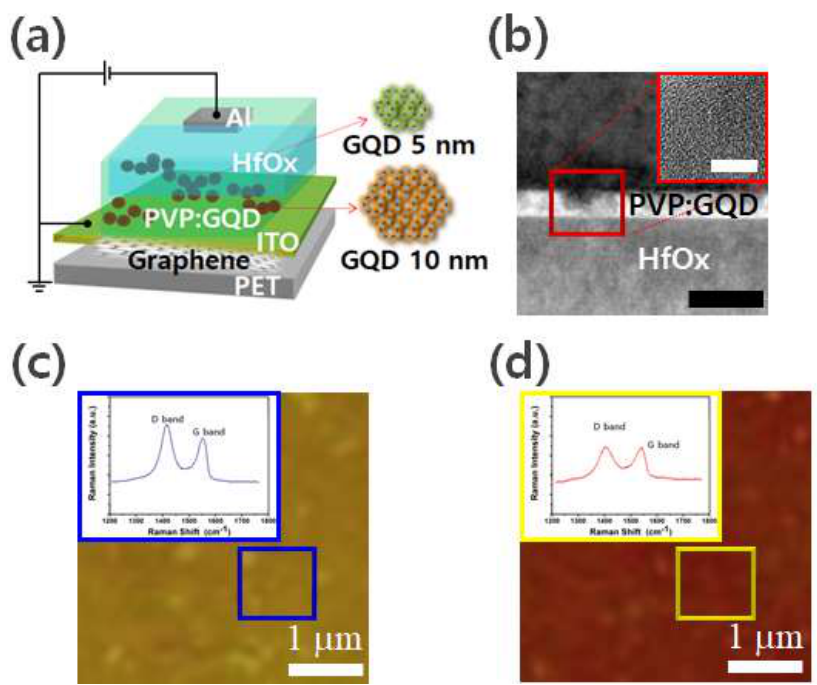
Figure 1. Schematic illustration ( a ) of the device architecture based on PVP GQD/HfOx/ITO/graphene. ( b ) and TEM image of PVP GQD/HfOx layer. The scale bar indicates 20 nm. Inset on right panel: high-resolution TEM image showing GQDs. Scale bar, 5 nm. Characterization of chemical state in the GQD layers, the ON and the OFF state. Raman intensity ratio maps of D and G bands at ( c ) ON state, and ( d ) OFF state. Inset: Raman profiles of the blue and yellow box in ( c , d ).